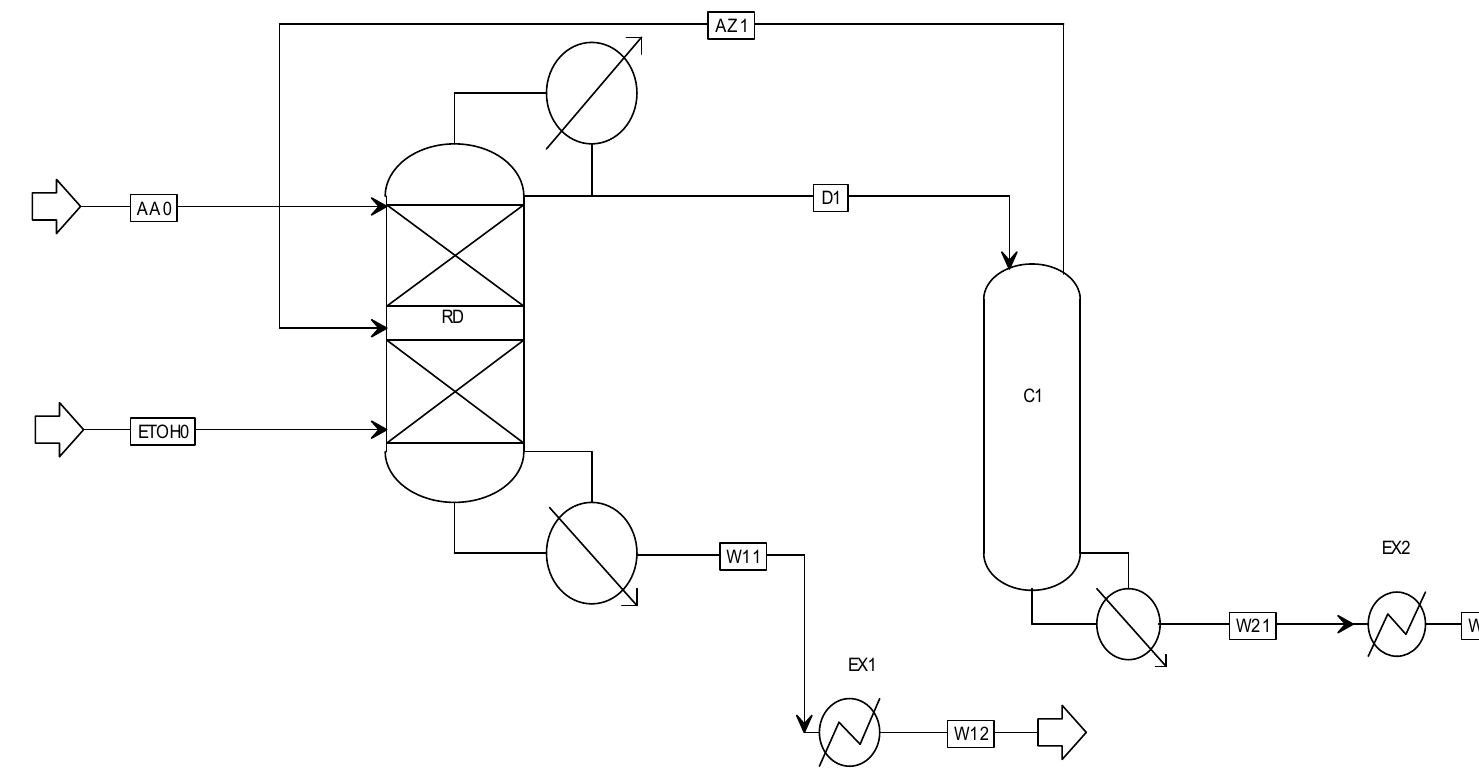
Figure 3. Ethyl acetate production via reactive distillation column with a stripper.